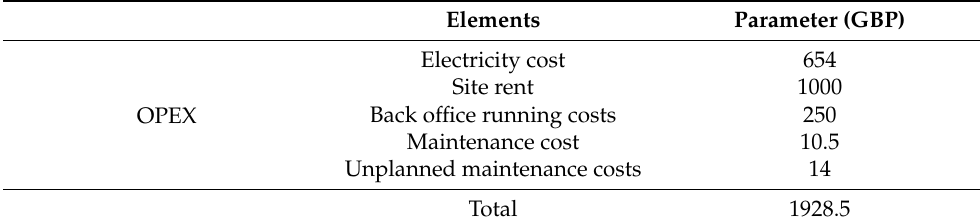
Table 18. Summary of improved OPEX of County Durham (Year 1).